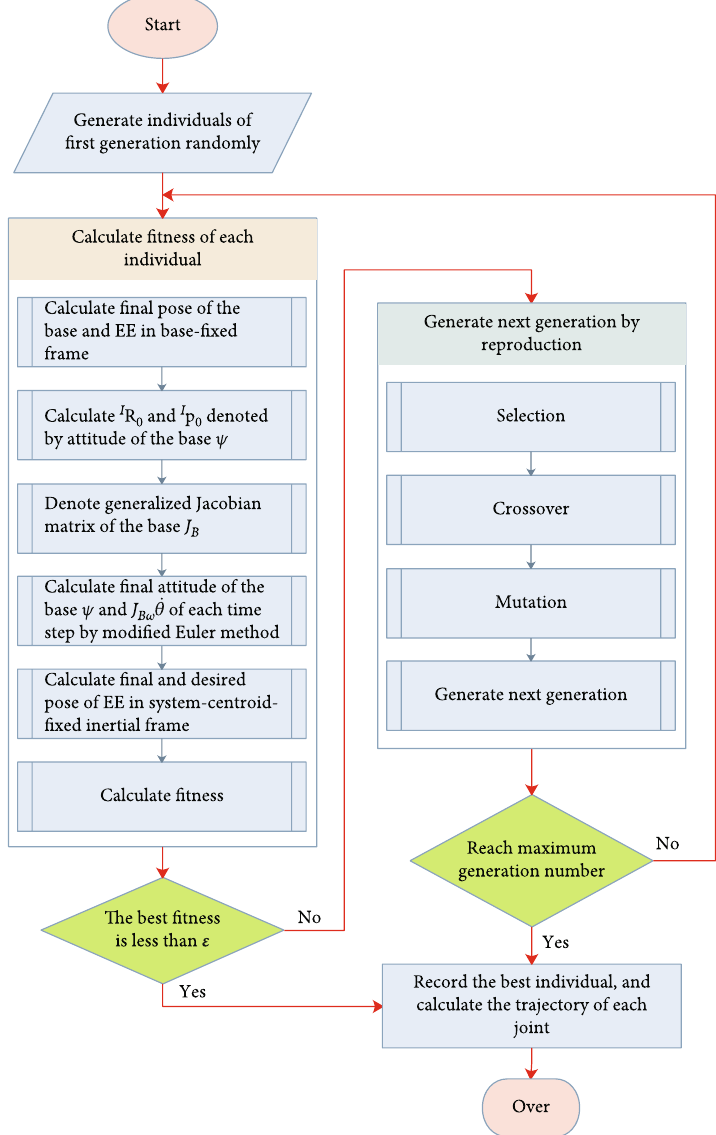
Figure 3: Flowchart of the provided trajectory planning